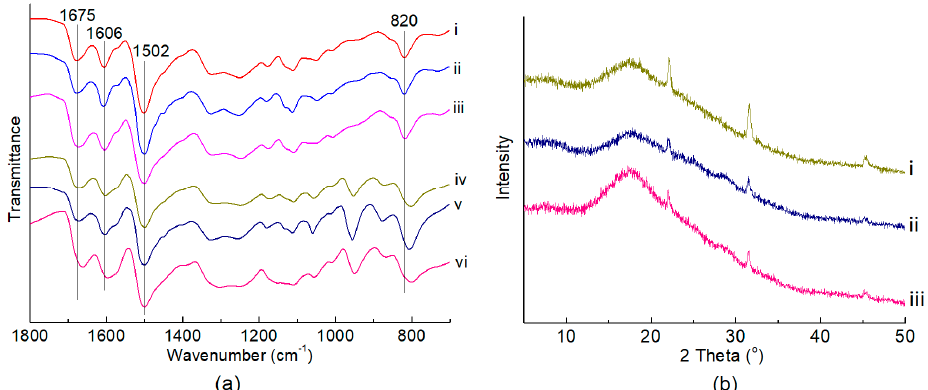
Figure 3. ( a ) FTIR spectra of F y -PAN and 40 -PMo 12 / F y -PAN. ( i ) F 1 -PAN, ( ii ) F 2 -PAN, ( iii ) F 3 -PAN, ( iv ) 40 -PMo 12 / F 1 -PAN, ( v ) 40 -PMo 12 / F 2 -PAN, ( vi ) 40 -PMo 12 / F 3 -PAN. ( b ) XRD patterns of 40 -PMo 12 / F y -PAN catalysts. ( i ) 40 -PMo 12 / F 1 -PAN; ( ii ) 40 -PMo 12 / F 2 -PAN; ( iii ) 40 -PMo 12 / F 3 -PAN.